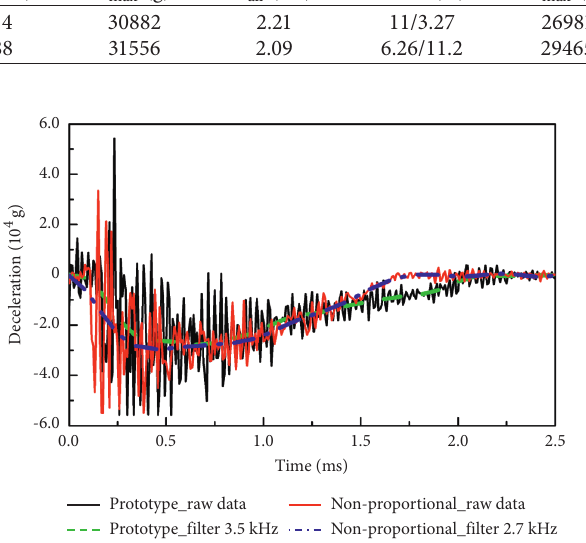
Figure 14: Experimental deceleration-time curves of the prototype and nonproportional scaling model. Table 8: Detailed comparison of rigid-body deceleration between the prototype and scaling model.